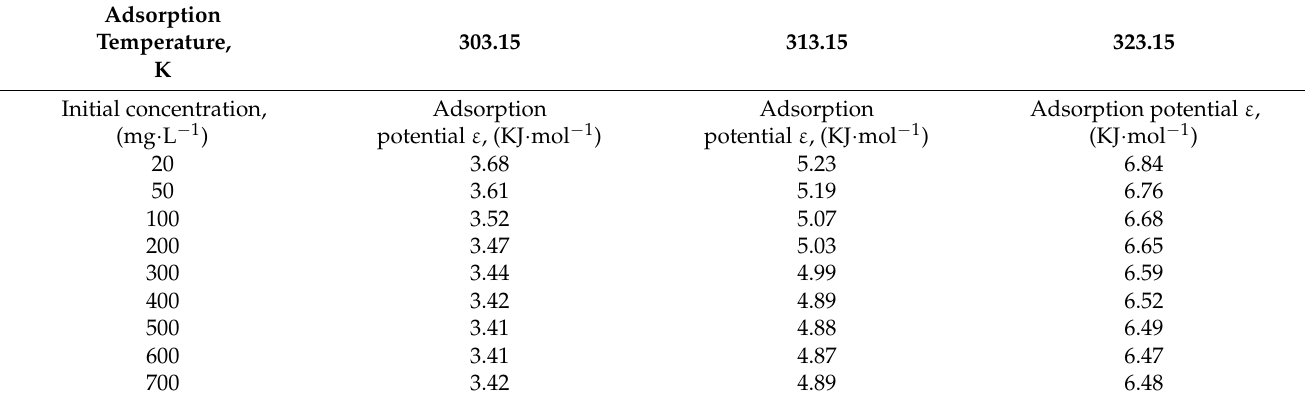
Table 4. Change of adsorption potential of MB on chestnut shell-based activated